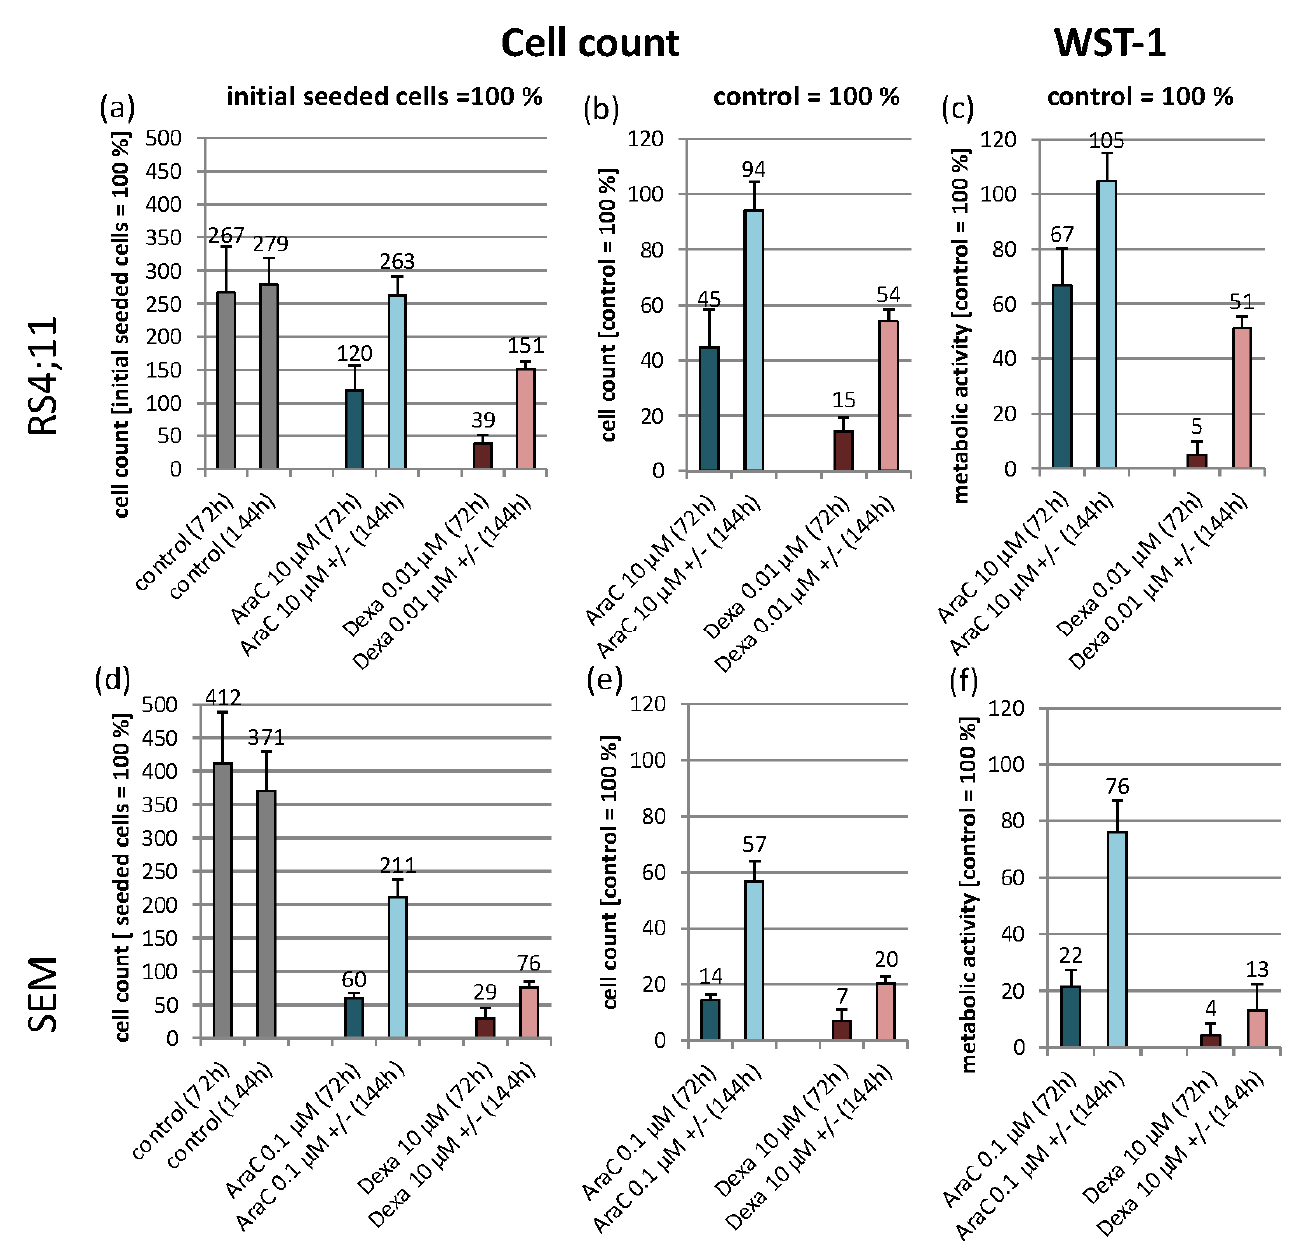
Figure 2. Cell count and metabolic activity in RS4;11 ( a – c ) and SEM ( d – f ) in response to AraC and Dexa for 72 h. After 72 h, drugs were released and cells cultivated for another 72 h (144 h+/−). Cell count ( a , b , d , e ) and WST-1 proliferation assay ( c , f ) were performed after 72 h and 144 h. The control cells and drug exposure times were compared with the Students’ t -test at significance levels of * p ≤ 0.05, ** p ≤ 0.01, *** p ≤ 0.001, [ n ≥ 3].